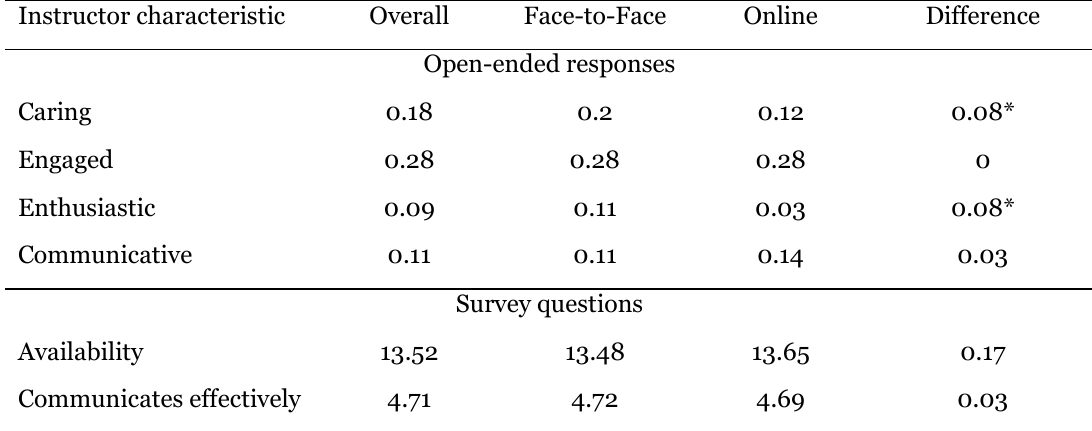
Difference of Means Tests Comparing Best Face-to-Face and Online Classes: Instructor